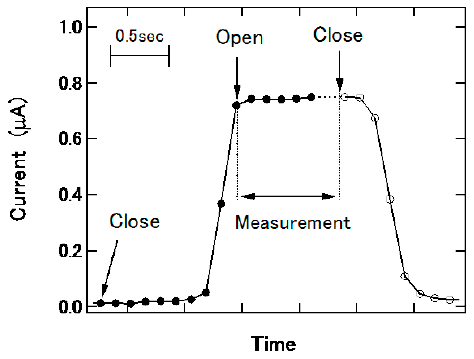
Figure 3. Detection of the plug by the photocurrent signal.